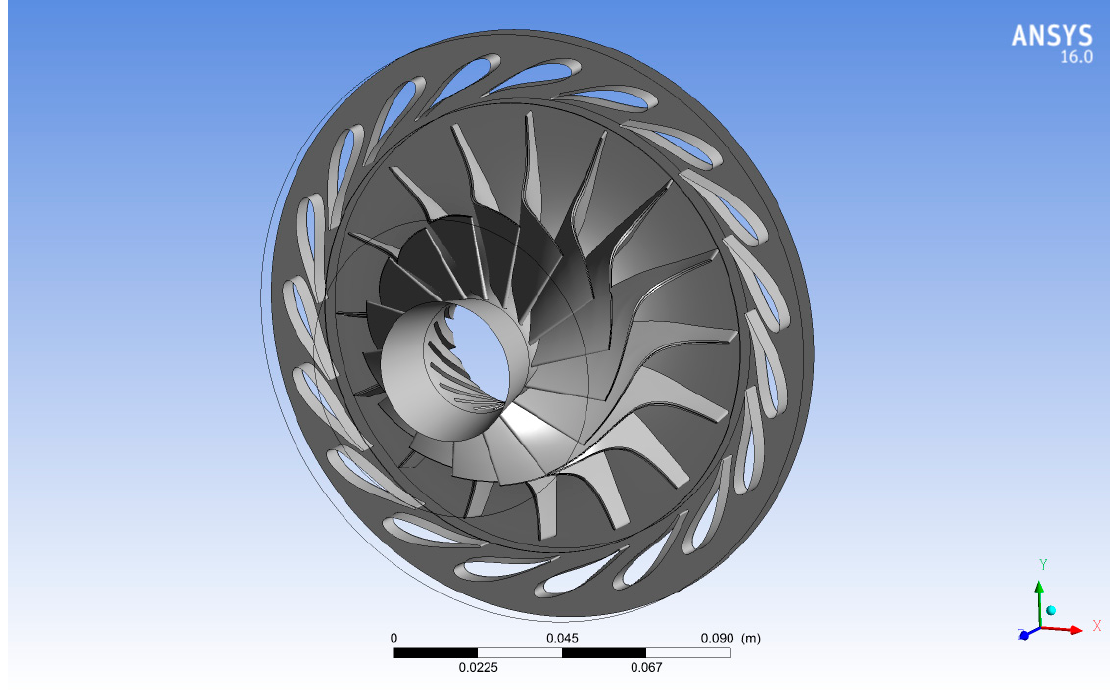
Figure 3. Three-dimensioanl model of the radial inflow turbine.